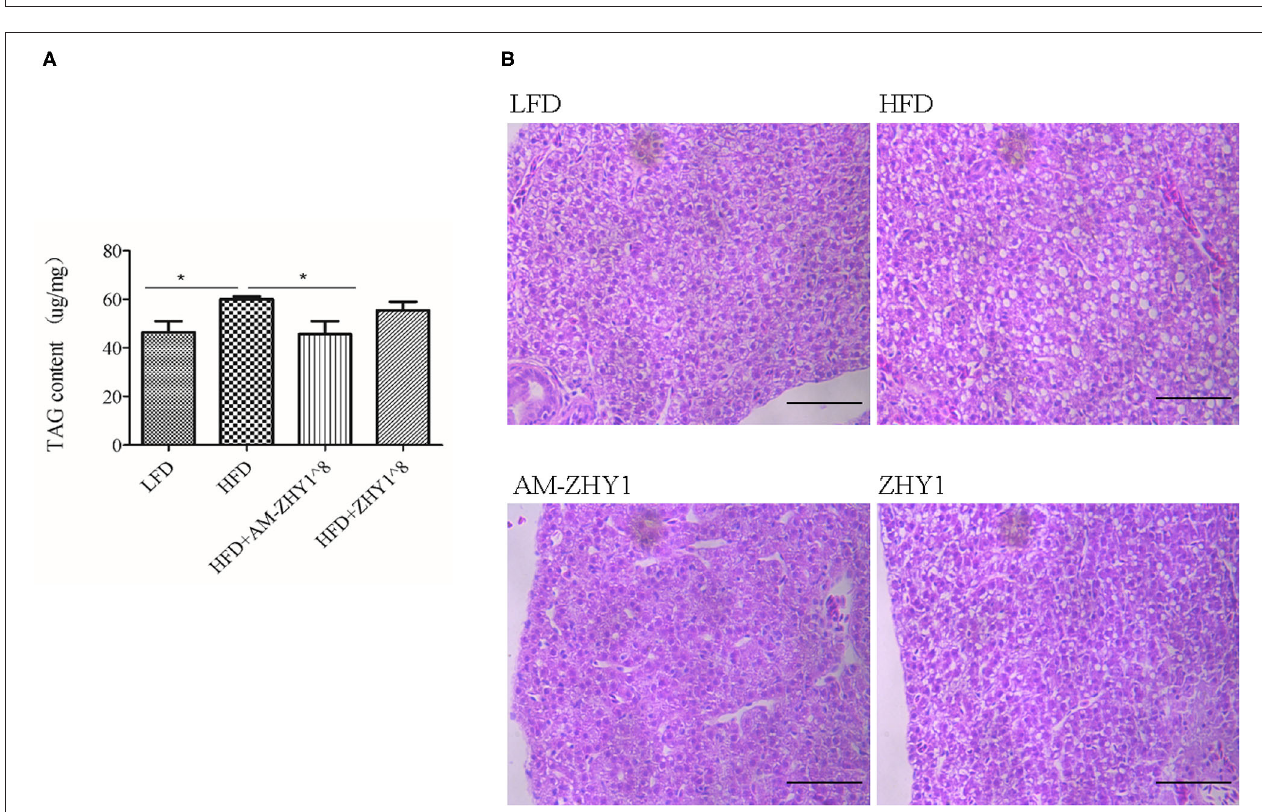
FIGURE 4 | Triacylglycerol (TAG) content of the livers of zebrafish in different groups. (A) TAG content of the liver, the significance level was determined by a Student’s t -test (* p < 0.05). (B) Histological changes of liver sections measured by HE staining (scale bar is 50 µ m).